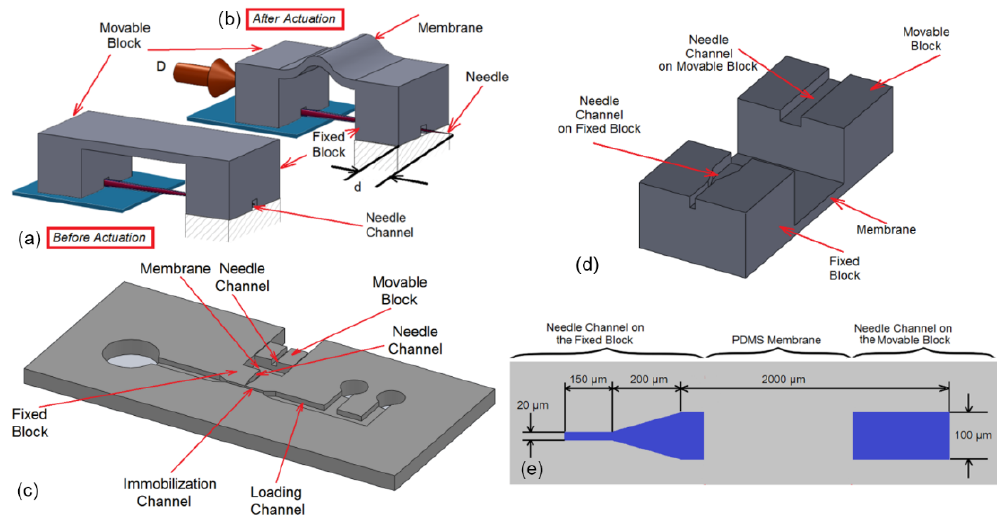
Figure 3. ( a , b ) The conceptual design of the compliant mechanism. ( a ) Before actuation. ( b ) After